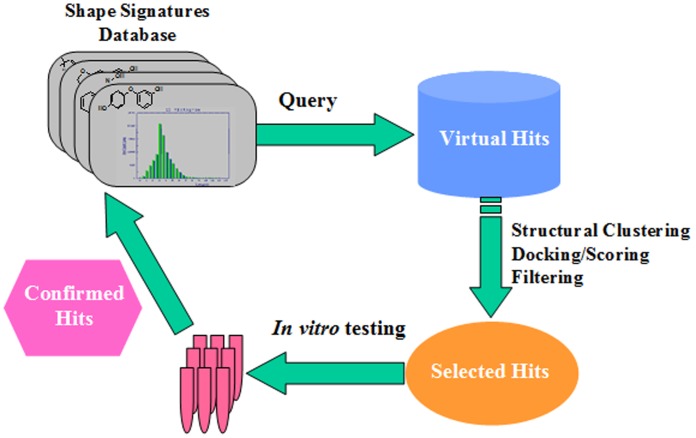
Overview of computational procedure employed in this study to identify potential tyrosinase inhibitors.Experimentally positive virtual hits are fed back to the server and the process is repeated iteratively to achieve the optimum lead compound.